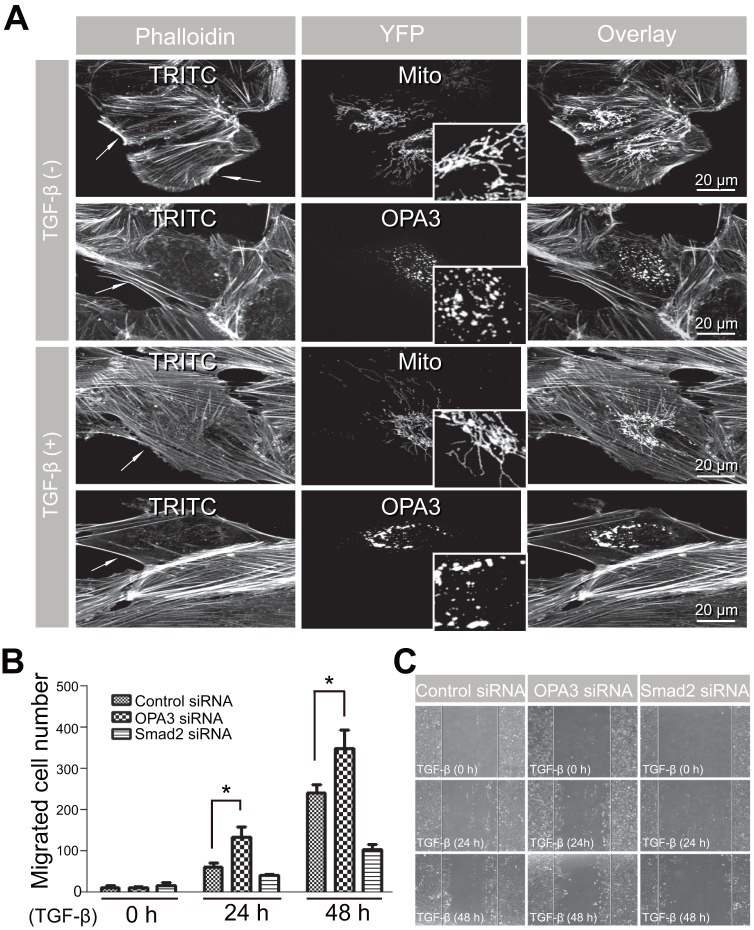
Overexpression of OPA3 prevented the rearrangement of F-actin in response to TGF-β treatment in ARPE-19 cells.(A) Inhibition of F-actin rearrangement by OPA3 overexpression. APRE-19 cells were transfected with OPA3-YFP and mito-YFP, respectively. Fifteen hours after transfection, cells were incubated in the absence or presence of TGF-β for 48 h. Cells were fixed and stained with phalloidin-TRITC. White arrows indicate YFP-positive ARPE-19 cells. Higher magnification images of mitochondria are presented in the inset panels. (B and C) Effect of OPA3 in TGF-β-induced cell migration. Cells were transfected with the indicated siRNAs. Forty-eight hours after transfection, cells were treated with TGF-β for the indicated periods of time. The migrated cells were counted (B) and photographed (C). Data shown represent the average of three independent experiments. *P<0.05.